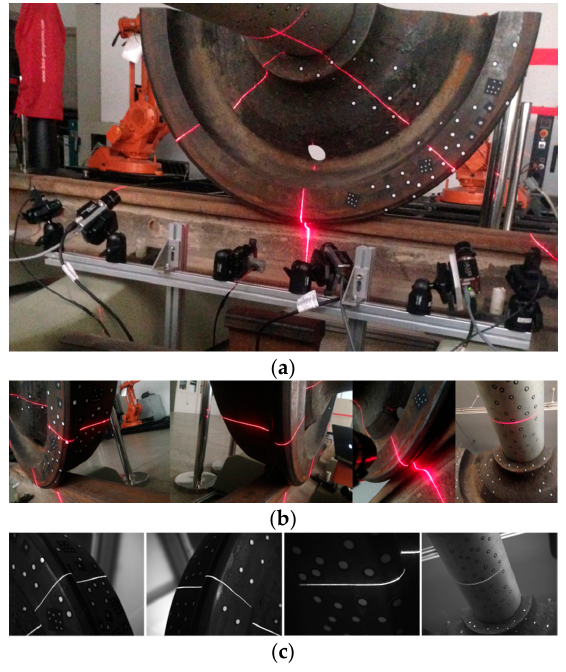
Figure 18. The static experiment. ( a ) The experiment platform; ( b ) the laser profiles on the wheelset; ( c ) the laser images captured by the cameras.